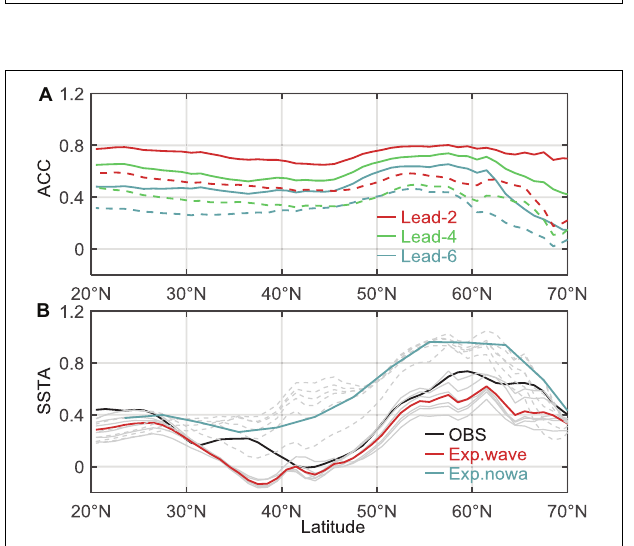
FIGURE 9 | (A) Zonal mean ACC (110 ◦ E–100 ◦ W) between IOSST v2 datasets and hindcast results in EAKF (solid line) and Projection-OI (dashed line) runs. Red, green, and blue lines represent for 2-, 4-, 6-month lead, respectively. (B) Zonal mean SSTAs (110 ◦ E–100 ◦ W; units: ◦ C) with respect to 1993–2017 climatology in observation (black), Exp.wave (red) and Exp.nowa (blue) mean averaged for 1–6 lead months, and gray solid and dashed lines represent the different lead month in Exp.wave and Exp.nowa.